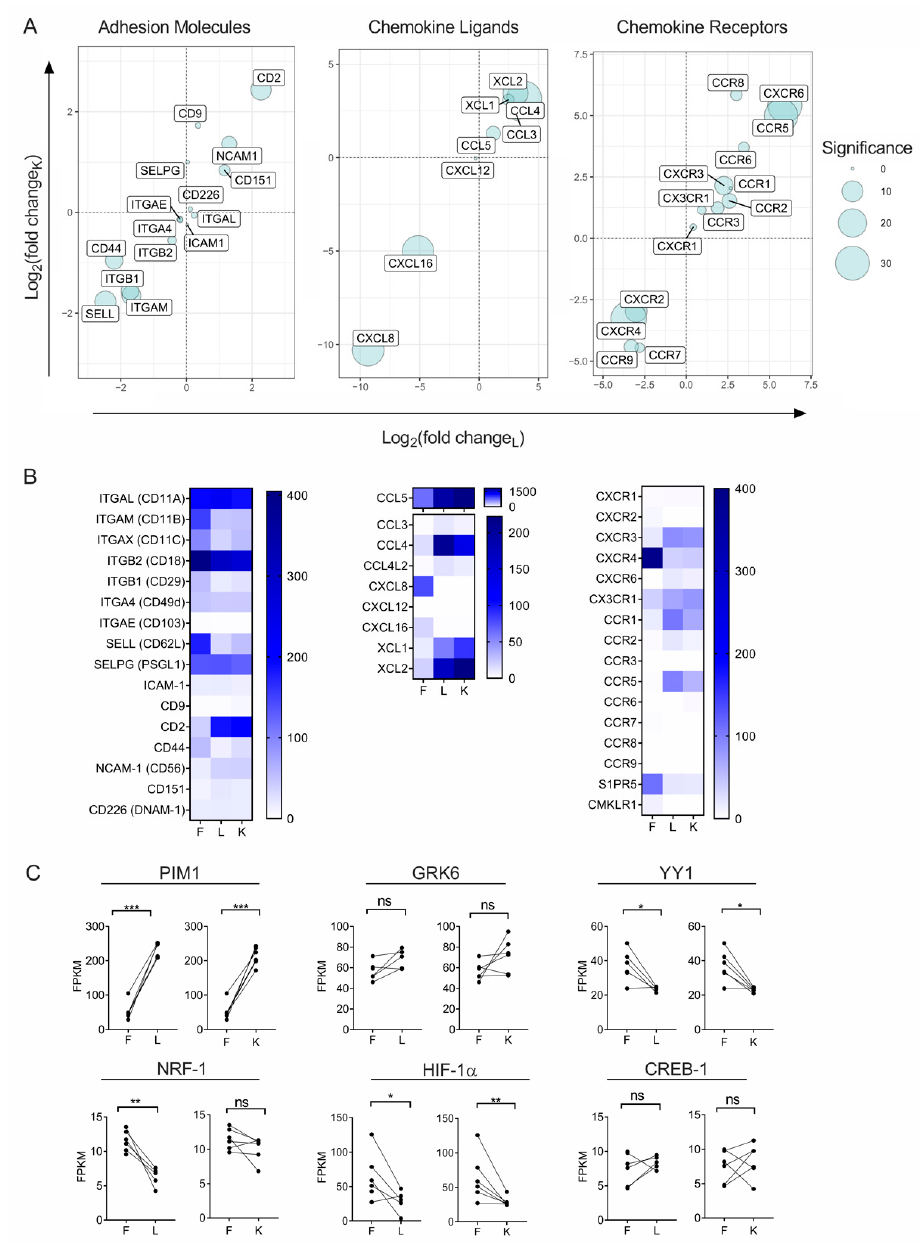
Figure 3. Ex vivo expansion of NK cells leads to a highly significant transcriptional alterations in genes that govern cellular trafficking. ( A ) Bubble plots that displays genes that control NK in vivo trafficking; Graphical organization is the same as in Figure 2A. ( B ) Heat maps that report FPKM values for the genes that are graphed in (A). ( C ) Line graphs showing the change in transcription of genes that regulate CXCR4 in NK cells from fresh (F) to expanded with either LCL feeder cells (L) or GE-K562 feeder cells (K), from individual donors. The paired t -test was used to determine significance, ns = not significant, * p < 0.05, ** p < 0.01, *** p < 0.001. Among adhesion molecules, the most notable changes in transcription occurring with ex vivo NK cell expansion was a decrease in CD62L (approximately 5-fold, adjusted p = 1.82 × 10 − 11 ) and a strong increase in CD2 (approximately 4-fold, p = 4.0 × 10 − 11 ) (Figure 3A,B). Genes that are responsible for the downstream signaling of chemokine receptors, including genes involved in mitogen-activated protein (MAP), Rho-associated, and phosphoinositide-3 (PI3) kinase signal cascades, remained unchanged (Figure S3). We also assessed changes in gene expression of CXCR4 transcriptional regulators and